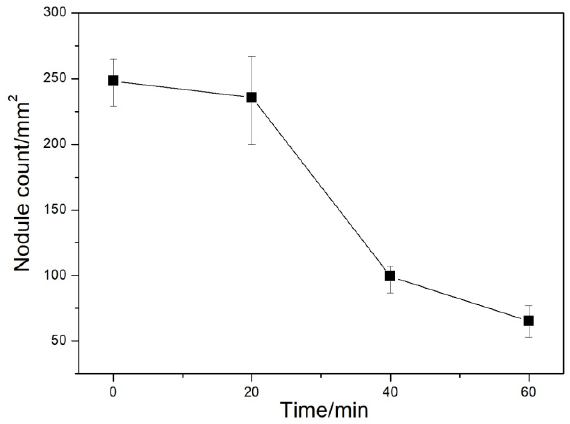
Figure 5. Nodularity of DI by injecting nitrogen gas at different time periods.